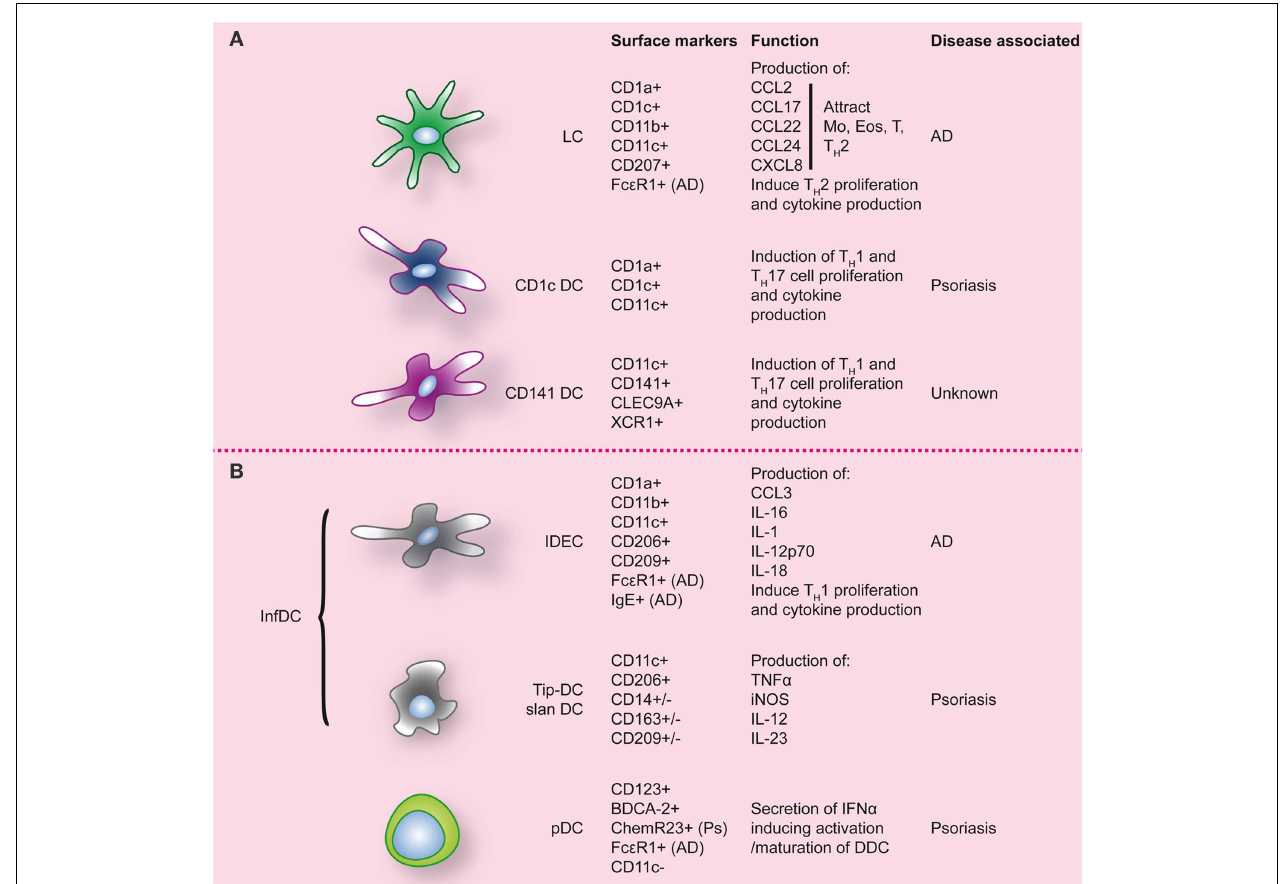
commonly used to identify these DC populations are indicated, as well as markers/function associated with specific inflammatory conditions of the skin. LC, Langerhans cell; Ps, psoriasis; AD, atopic